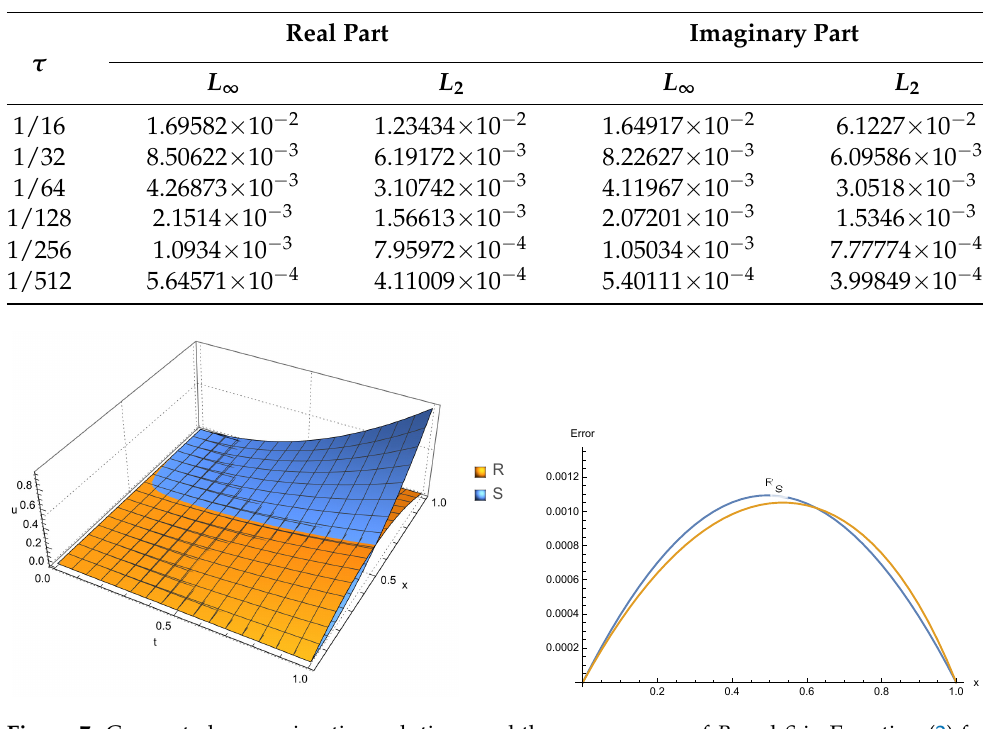
Figure 7. Computed approximation solutions and the error curves of R and S in Equation (2) for α = 0.1 τ = 1/256, a = 0, b = 1, and N = 40.